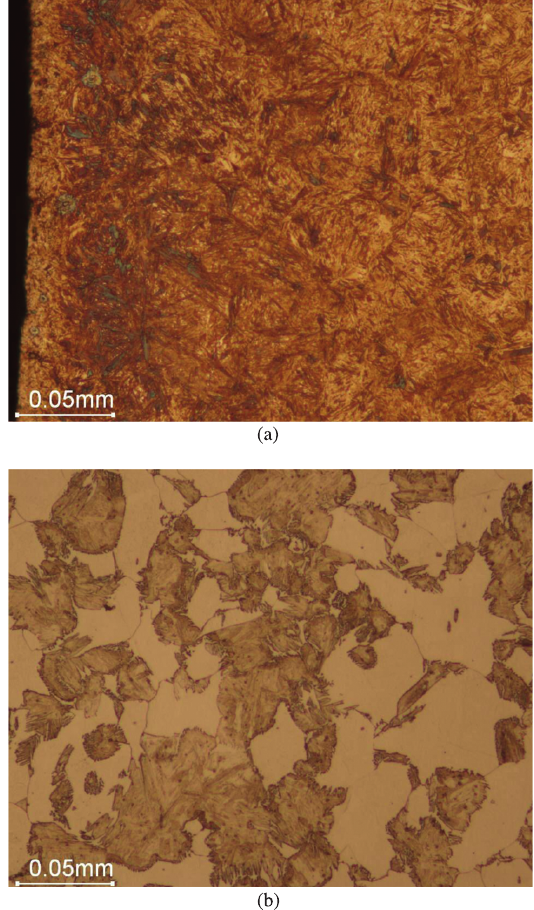
Figure 2. (Color online) Microstructure of 9520, for surface (a) and core (b).